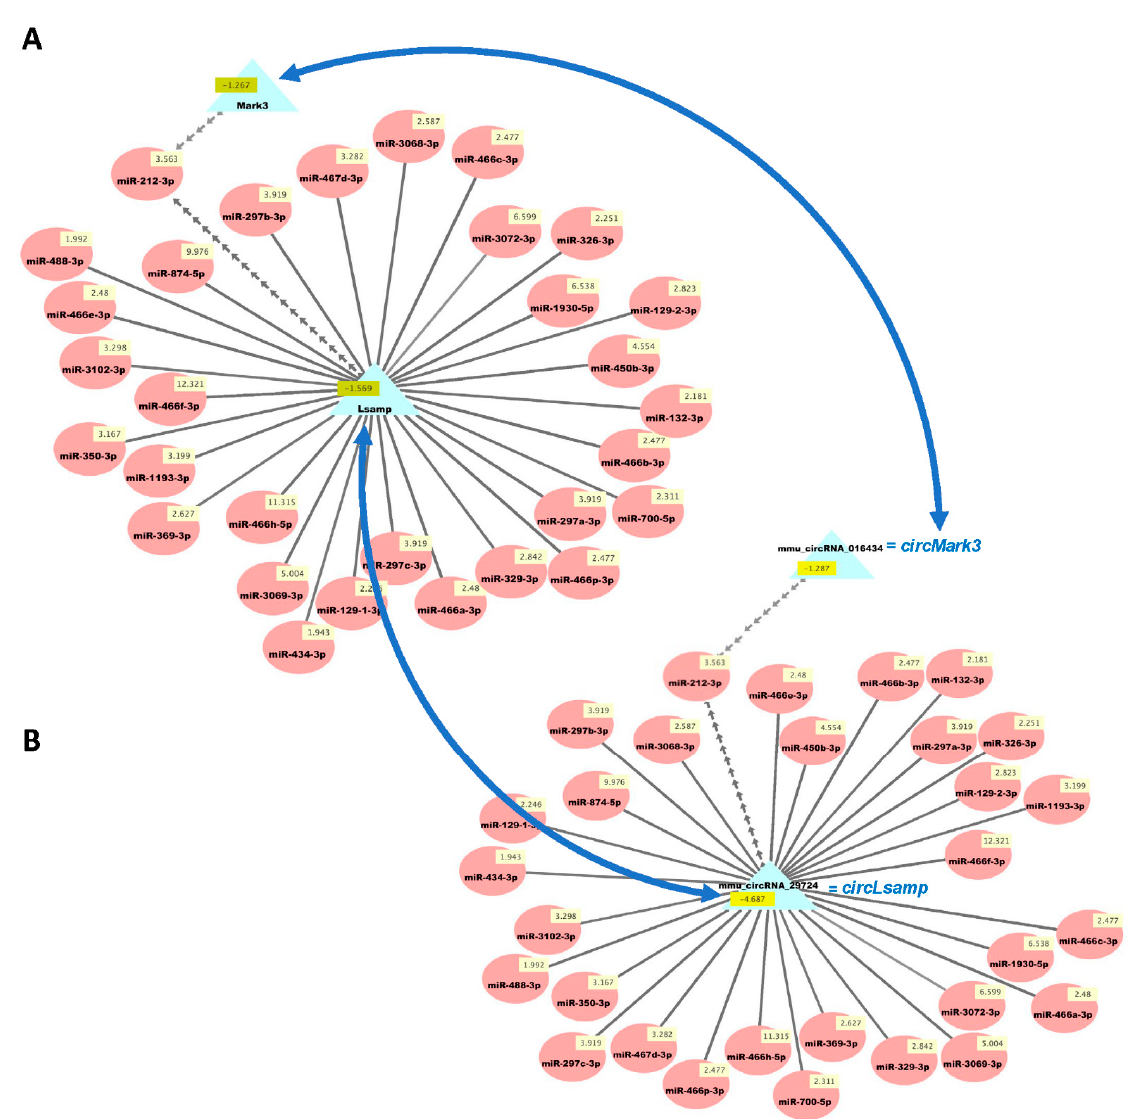
Figure 5. Cytoscape visualizations of predicted ceRNA interactions between significantly upregulated miRNAs in HuD KO striatum and significantly downregulated mRNAs ( A ) and circRNAs ( B ) derived from the same genes. Panels show that the mRNA and circRNA for Lsamp are predicted to interact with a set of 30 upregulated miRNAs, and those for Mark3 are predicted to interact with miR-212-3p , as they have the same MRE sequences (Table S6). Numbers in yellow boxes represent the average levels of the miRNAs, mRNAs, and circRNAs in HuD KO mice. Multiple gray arrows indicate multiple predicted interactions and a single gray line, a single interaction. Blue arrows depict the potential competition of mRNAs and circRNAs for binding to the same miRNAs. See Methods and Figure S1 for further information.